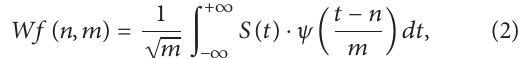
Figure 2: The flow chart of WCC extraction